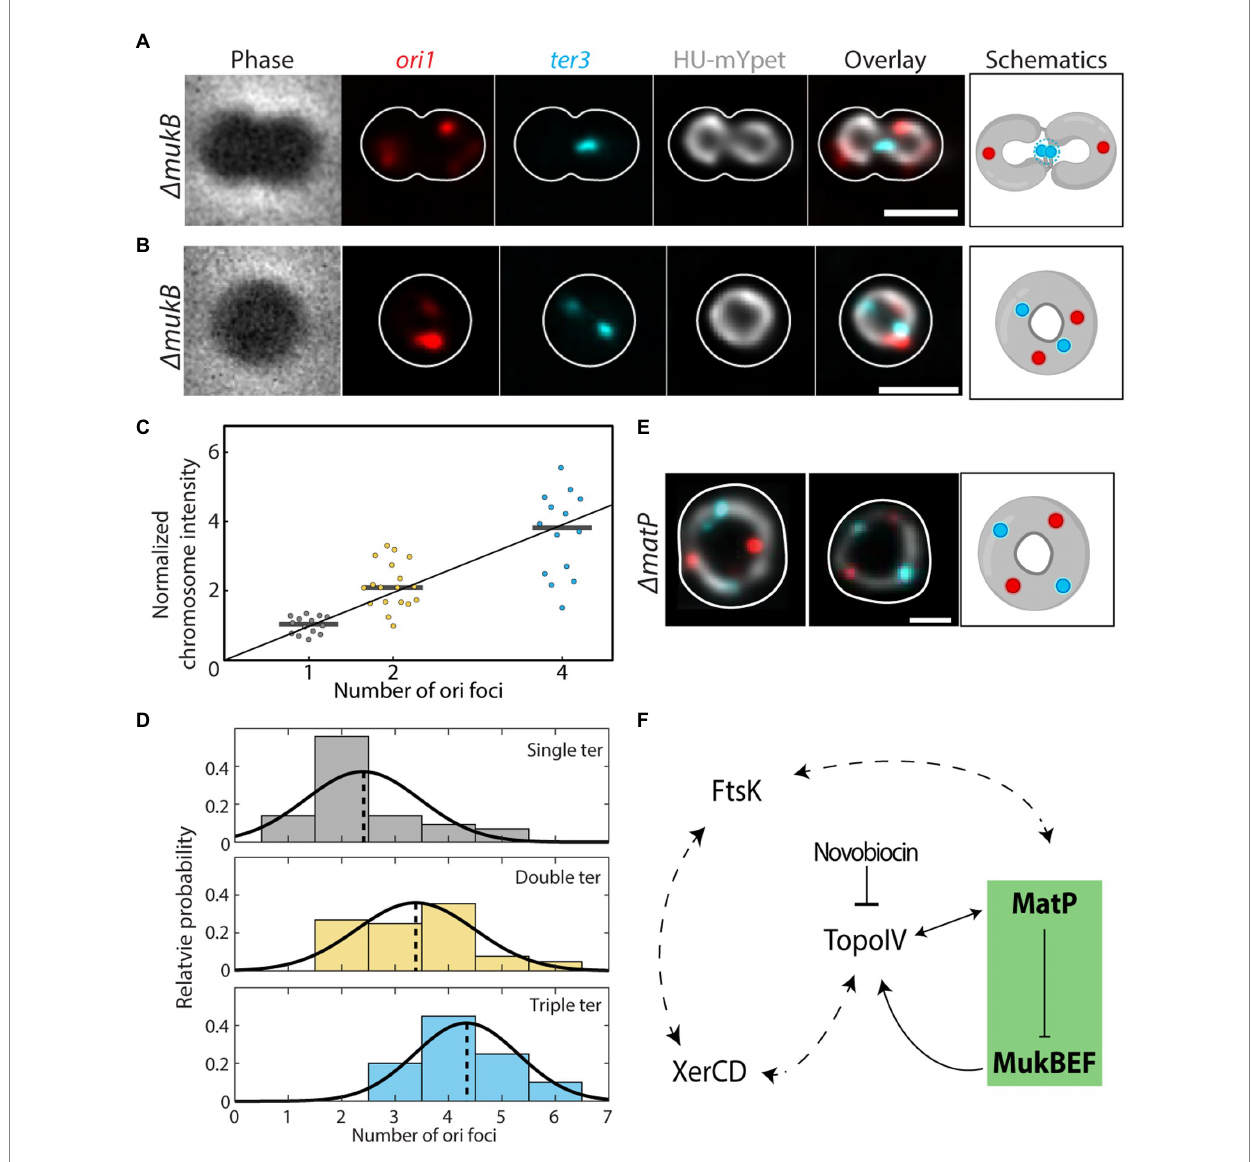
FIGURE 4 Impaired chromosome decatenation in Δ mukB and Δ matP cells. (A) Phase contrast and fluorescence signals of ori1 , ter3 , DNA (HU-mYpet) and an overlay for a typical Δ mukB cell widened with A22 are shown. The cell outline is shown in white and the impaired decatenation is